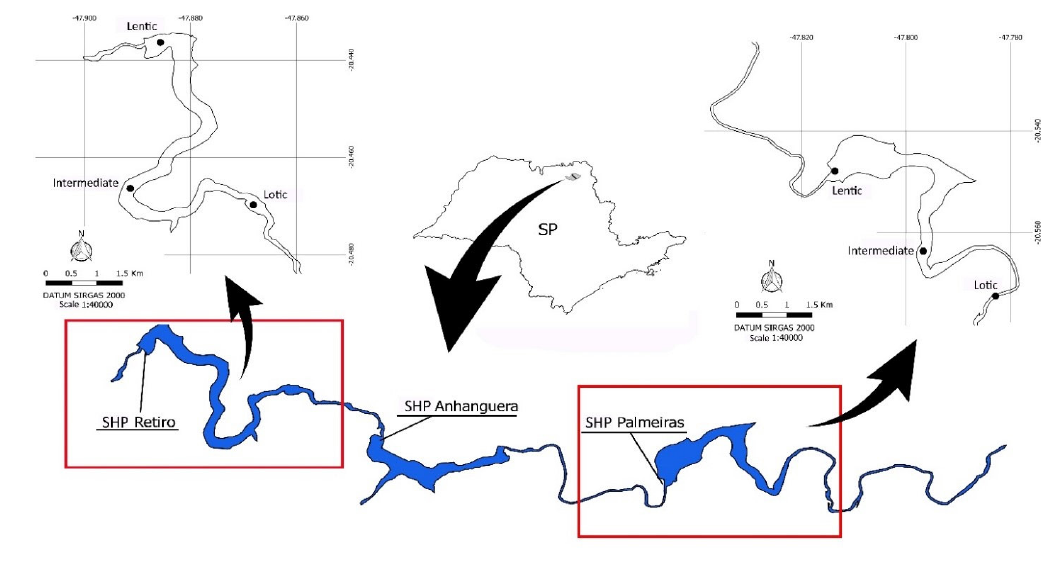
Figure 1. Map of the Sapucaí-Mirim River (SP, Brazil) stretch, where are located the studied Small Hydropower Plants (SHPs) reservoirs – Palmeiras and Retiro, with indication of the sampling